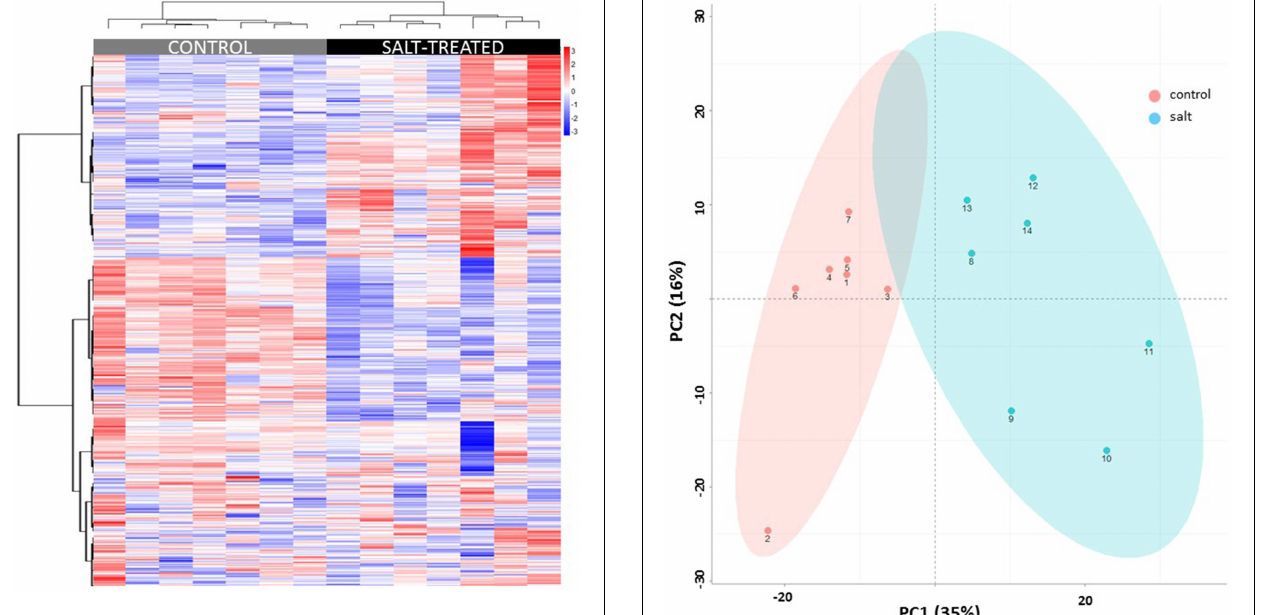
FIGURE 2 | Heatmap displaying similarities between biological samples organized by HCA. Multivariate sample similarities, displayed as a heatmap in which columns represent samples and rows metabolites. The heatmap visualization is used to encode individual measurements for each sample (autoscaled) as colors (red, relative increase; blue, relative decrease), as indicated by the color bar at top right of figure, all of which are organized using HCA. Metabolites are ordered on the heatmap in the order they appear in the list in Supplementary Table 2.